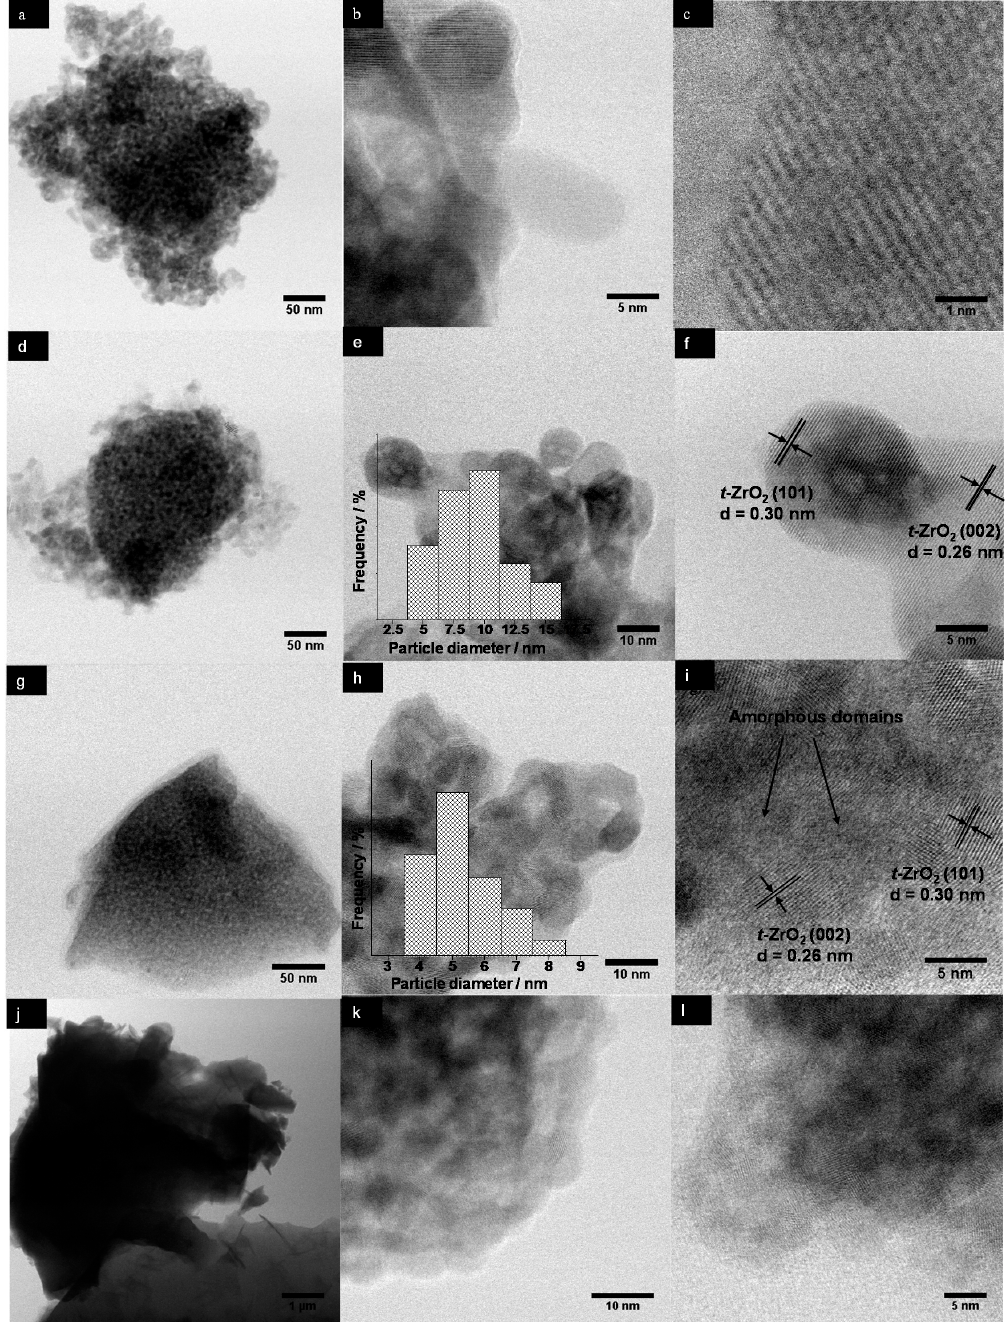
Figure 2. TEM and HRTEM images for: ( a – c ) 7.9MZ–HD; ( d – f ),18.2MZ–HD; ( g – i ) 8.7MZ–CT; and ( j